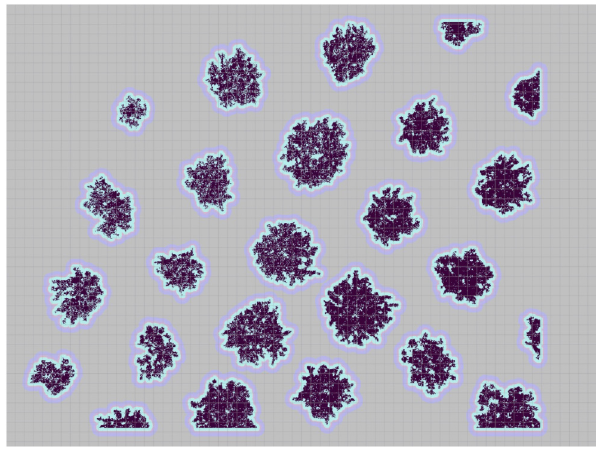
Figure 12. Generated map based on the ‘costmap_2d’ ROS package.